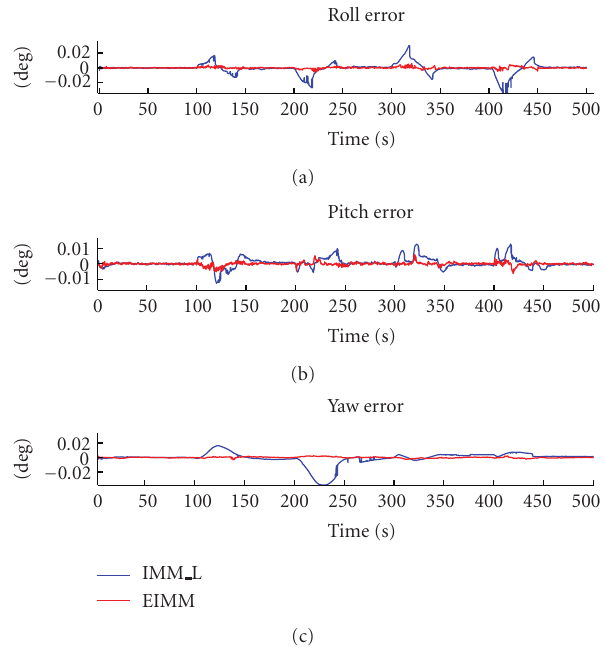
Figure 18: Estimation errors using IMM L and EIMMAE.